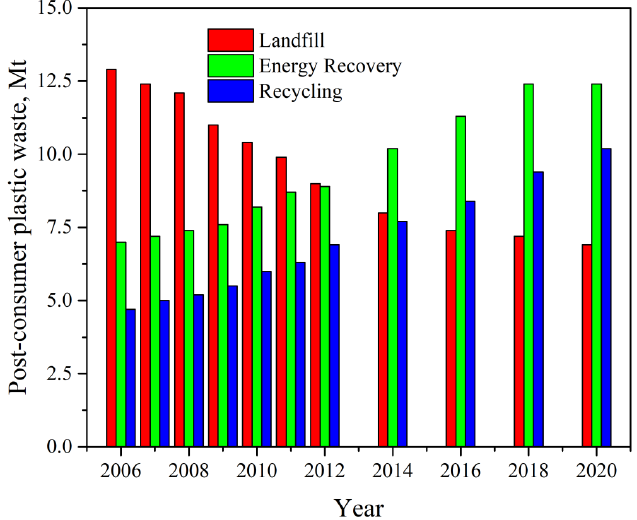
Figure 1. Evolution of post-consumer plastic waste treatment in Europe (red — landfill, green — energy recovery, blue — recycling) Data from [1]. Researchers have estimated that up to 12 million tons of plastic end up in the ocean every year, which is the equivalent of a rubbish truck every single minute [2]. In landfills, they accumulate rather than decompose. Recycling plastics is one of the many initiatives launched in Europe to turn waste into resources to create a circular economy for plastics. In the last decades, increasing interest has been focused on recycling plastic wastes [3 – 6]. Polyethylene terephthalate is one of the big six thermoplastics dominating the mar- ket. It is an acknowledged polyester with high mechanical strength, chemical inertness, and high dimensional stability [7]. The popularity of PET as a packaging material comes from several properties, especially its glass-like transparency and low weight, which, combined with flexibility and mechanical resistance, make packaging break-resistant [8,9]. It is a good barrier to gases, which enables the use of PET in the production of pack- aging intended for packing and storing carbonated beverages. PET can also be used in combination with other materials, including textile raw materials, which increases the strength of fabrics [10,11] . According to the Eunomia’s report in 2022 [12], the consump- tion of PET in Europe is dominated by beverage bottles (47% of overall EU PET demand), other single-use packaging (20%), and textiles and fibres (33%). Figure 2 represents market shares of PET in Europe. Focusing on single use bottles, 78% of them are made with clear PET, 20% from coloured transparent PET, and only 2% are opaque PET. Despite this low amount of 2%, the presence of opaque PET disturbs the existing recycling channels of PET as developed below.